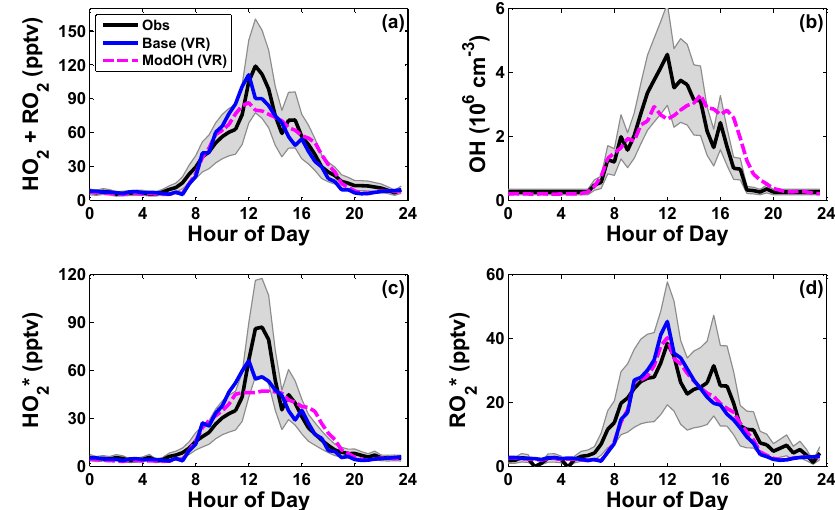
Fig. 11. Comparison of RO x observations with 0-D model results using the very reactive VOC mechanism. Solid black lines with shaded gray areas represent observations and their associated uncertainties. Model simulations include the base (solid blue line) and ModOH (dashed magenta line) scenarios augmented with very reactive VOC chemistry; in the latter case, OH concentrations are not constrained to observa- tions. For comparison with HO ∗ and RO ∗ in (c) and (d) , the total modeled RO 2 is subdivided into two groups as described in the text. Model 2 2 uncertainties are excluded for